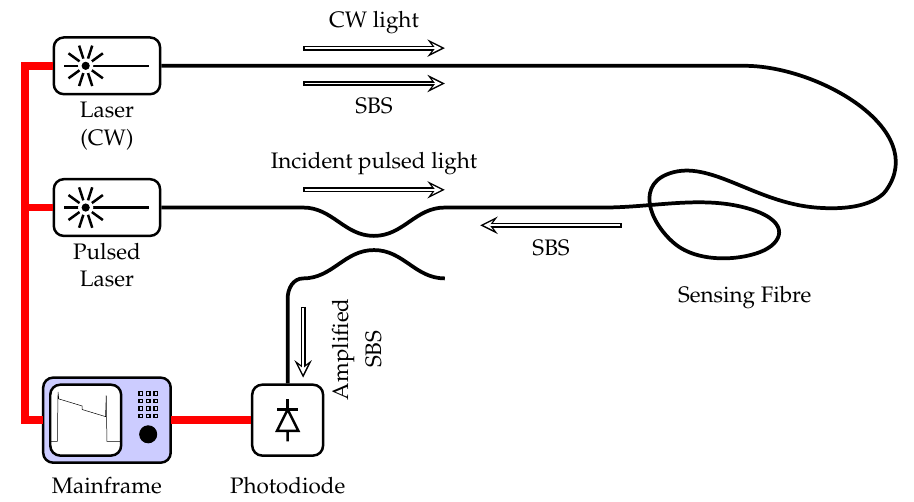
Figure 6. A typical configuration for a Brillouin optical time domain analysis (BOTDA) interrogator (SBS: stimulated Brillouin scattering) . After [78].